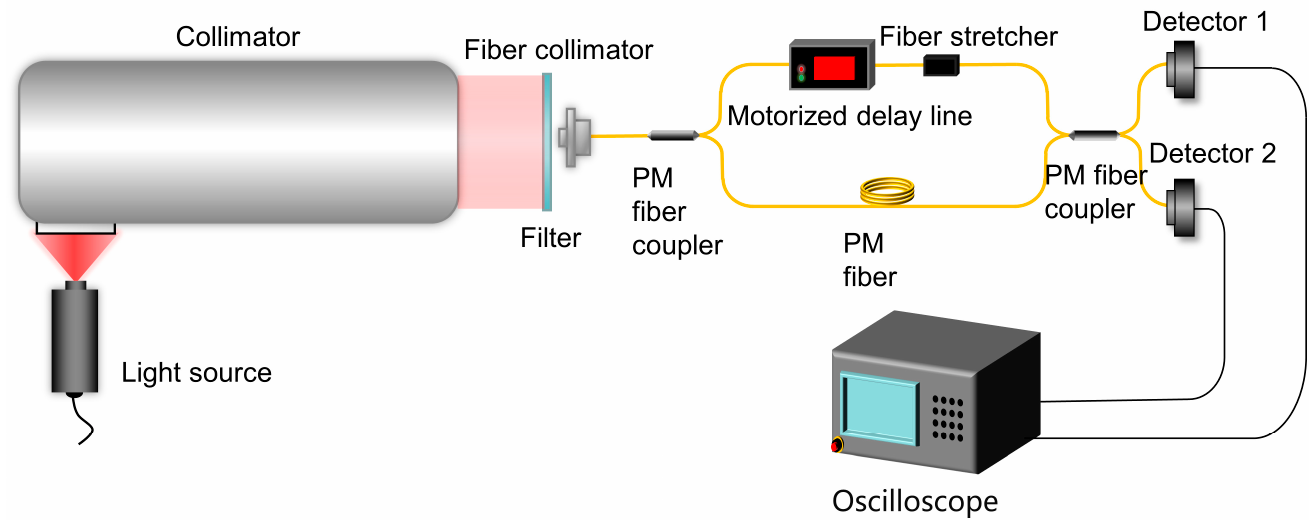
Figure 5. Layout of the experimental setup for amplitude-division interference. During the output of the experiment, the analog signal from the detector is recorded with an oscilloscope (Tektronix MSO3034), and the effective value (root mean square, RMS) of the detector noise is measured to be 3.5 pW. After the interferometric signal to be measured with a phase ϕ of the complex coherence factor passes through the 2 × 2 PM fiber coupler, there will be a phase shift of π due to the mode coupling, resulting in the 2 phase of the interferometric signals of the two outputs of coupler becoming ϕ + = ϕ + π 2 and ϕ − = ϕ − π , respectively [38,39]. That is, the phase of the two outputs will differ by 2 π . The validity and feasibility of the above method of measuring phase difference will be verified using these two interferometric signals with phase difference π